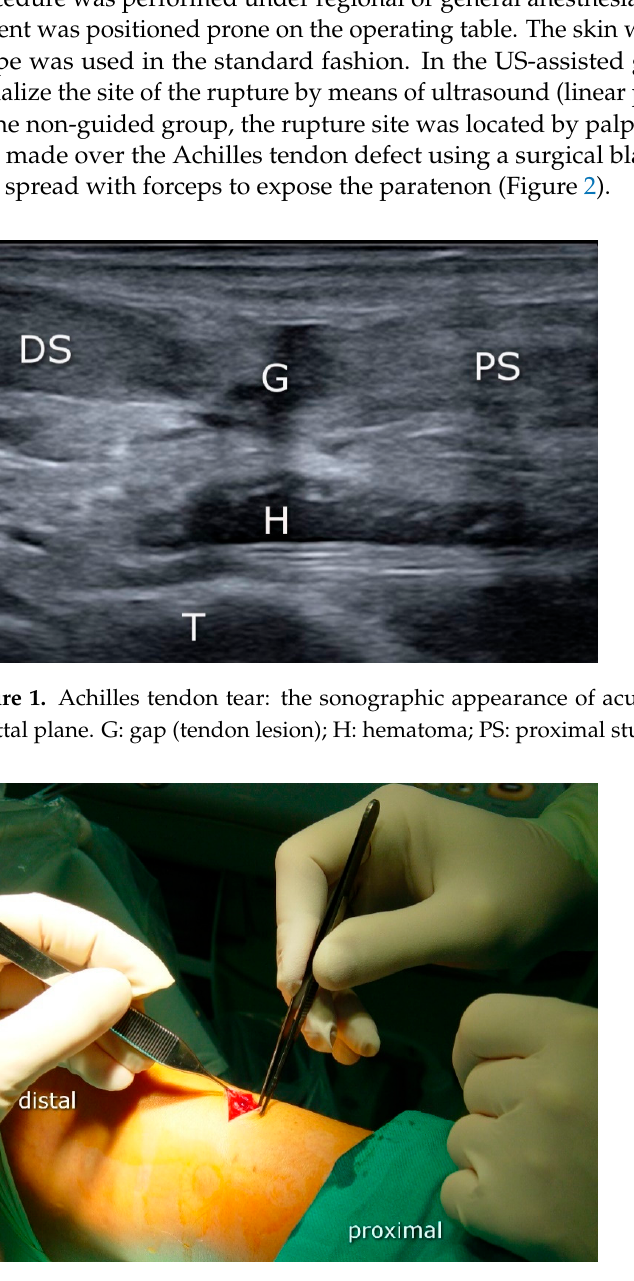
Figure 2. Skin cut: the first stage of surgery on the right Achilles tendon; the skin is transversely cut to make an approximately 2 cm incision directly over the tendon’s lesion, localized by means of US.